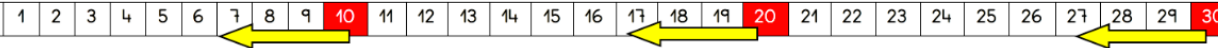
Figure 13. Number tape with some operations represented.